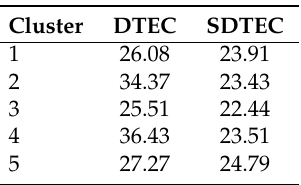
Table 3. The SDTEC and DTEC identification error rate